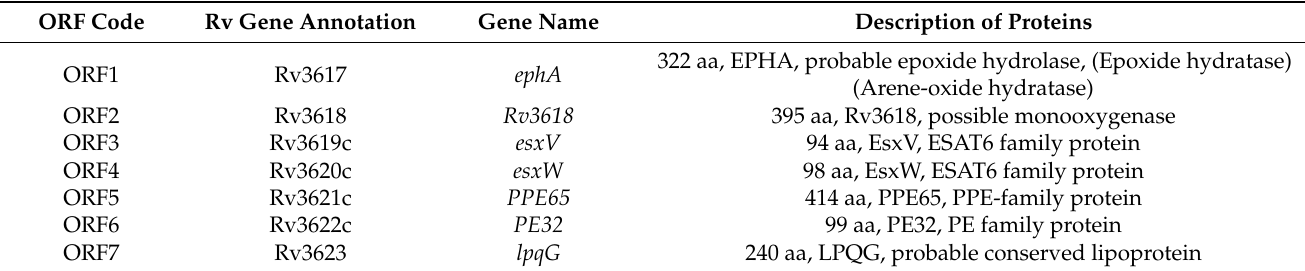
Table 4. ORF code, gene annotation, gene name and description of proteins encoded by genes in RD9. ORF